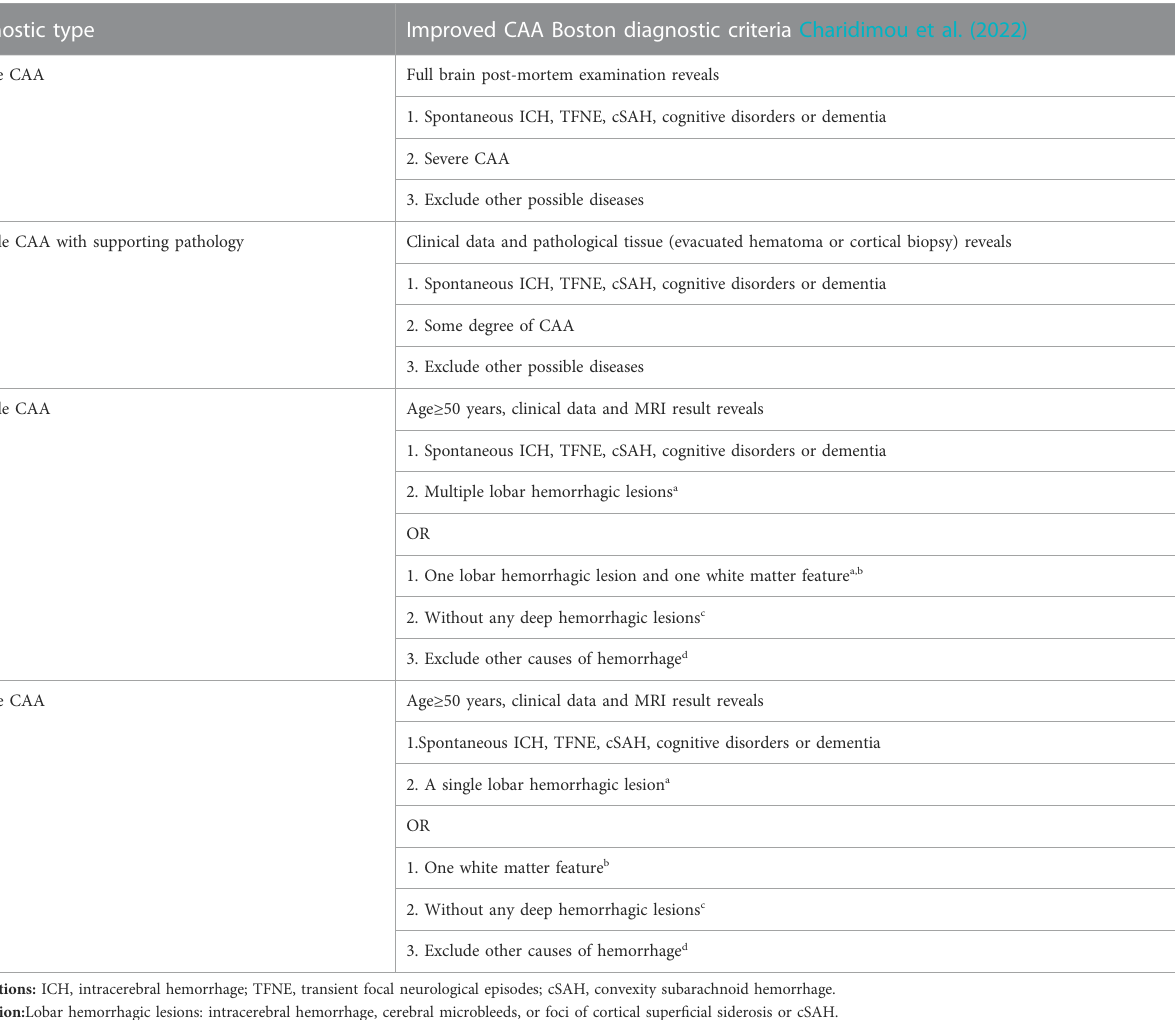
TABLE 3 Boston criteria version 2.0 for